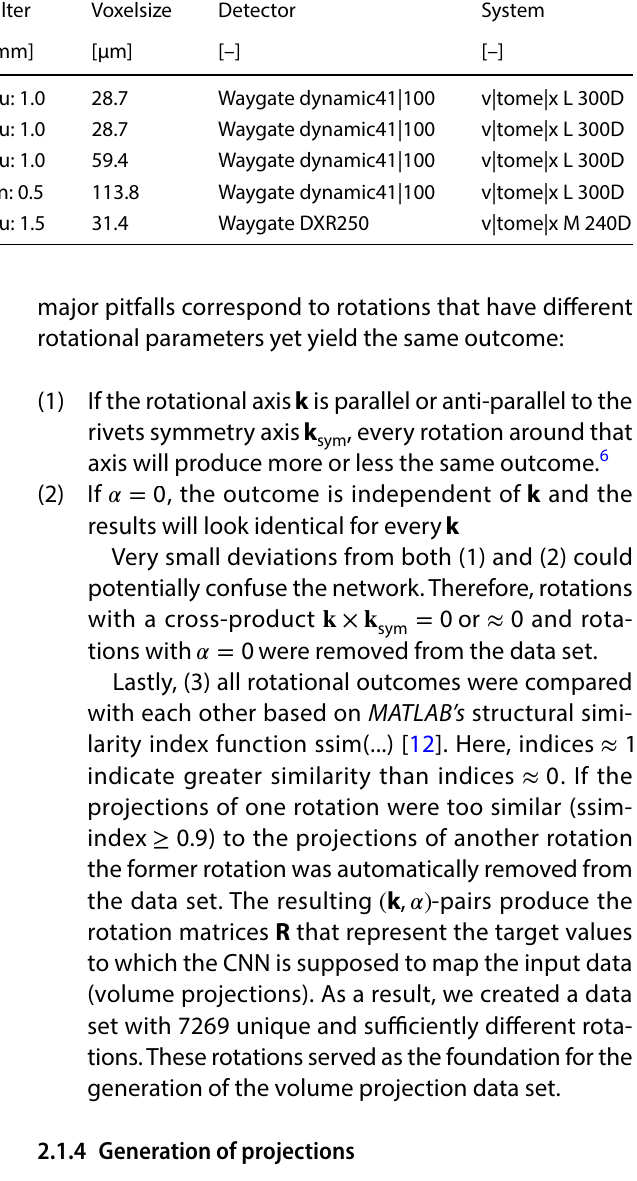
for focus-detector-distance, FOD: for focus-object-distance, and M: for the magnification. Rivet A and Rivet B were acquired in the same scan, hence the identical